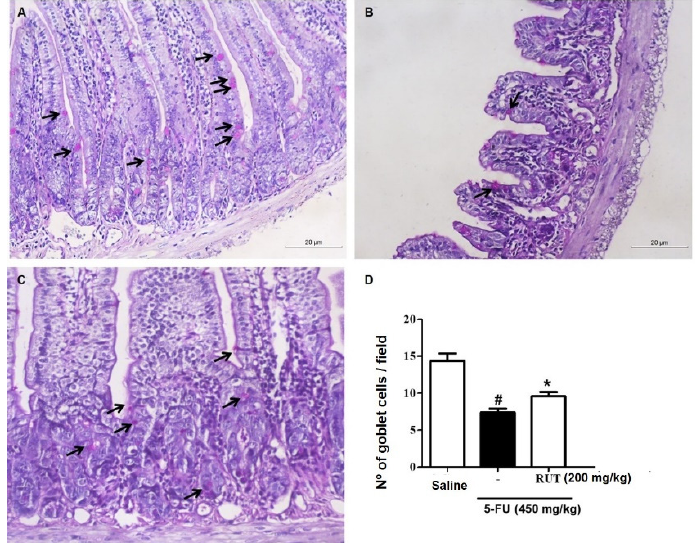
Figure 10. Goblet cell counts in the jejunal segment based on Schiff periodic acid (PAS) staining. Saline ( A ); 5-FU ( B ); RUT-200 ( C ); Statistical representation of experimental groups ( D ). Black arrows indicate goblet cells. Values are presented as mean ± SEM for the number of goblet cells per field. For the statistical analysis, one-way ANOVA was used, followed by Tukey’s test. # p < 0.05 in 5-FU vs. Saline group; * p < 0.05 in RUT-200 vs. 5-FU group. 5-FU, 5-fluorouracil; RUT, rutin.